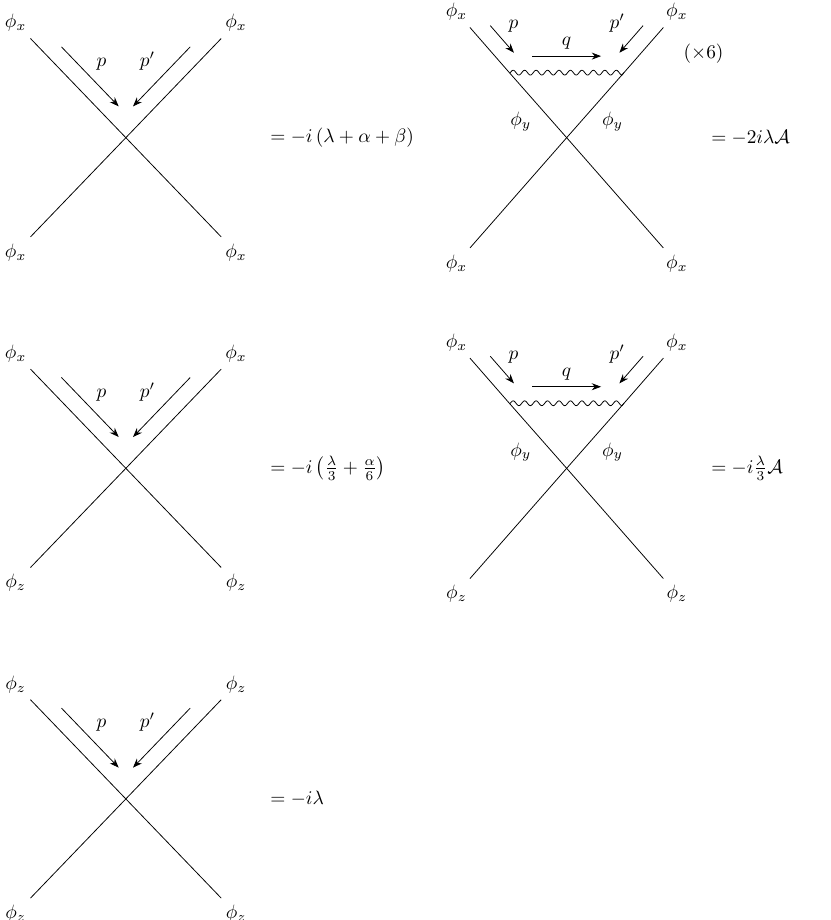
Figure 7 . A set of diagrams that can be used to evaluate the one-loop corrections to λ , α and β . The left column of diagrams shows the tree-level contributions of each term; note the combinatorial factors of 1 / 3 that appear in vertices with mixed φ fields when using the normalization conventions in (2.1). The right column shows the one-loop diagrams that contribute to each vertex; note that there is no one-loop correction to φ 4 , since φ z does not couple to the (hidden) photon. There are 6 z copies of the diagram in the upper-right, with the photon loop between different pairs of external lines. In both one-loop digrams, A is an integral defined and evaluated in the